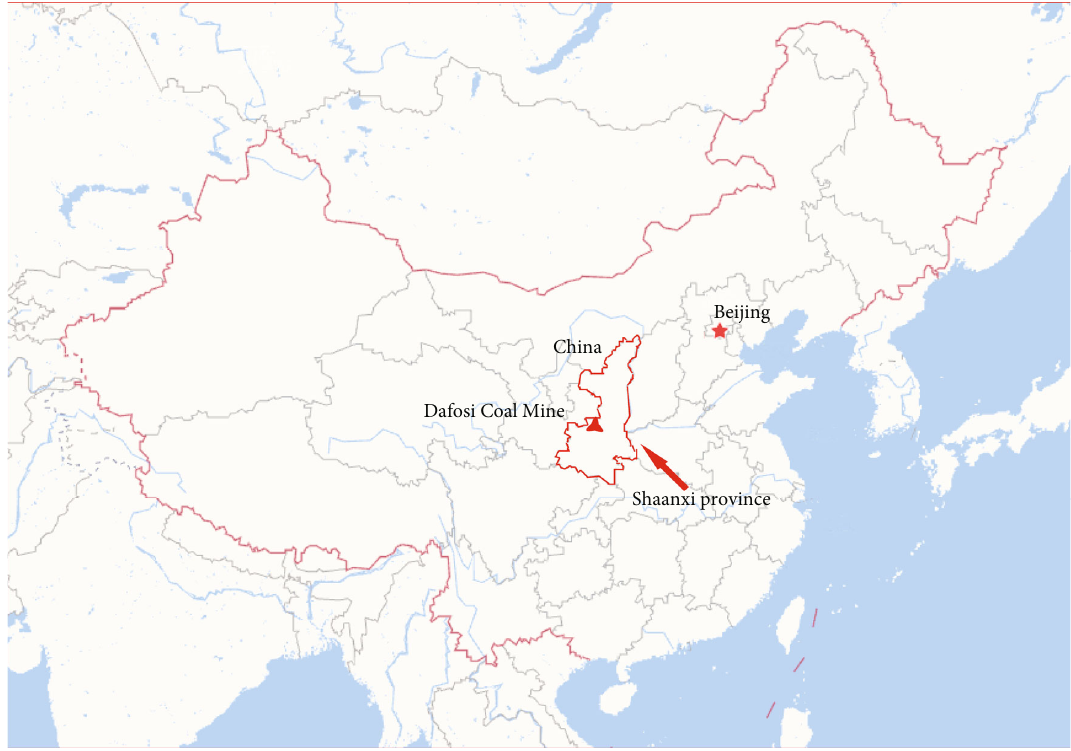
Figure 1: Location of the Dafosi Coal Mine, where the studied red sandstone was collected.